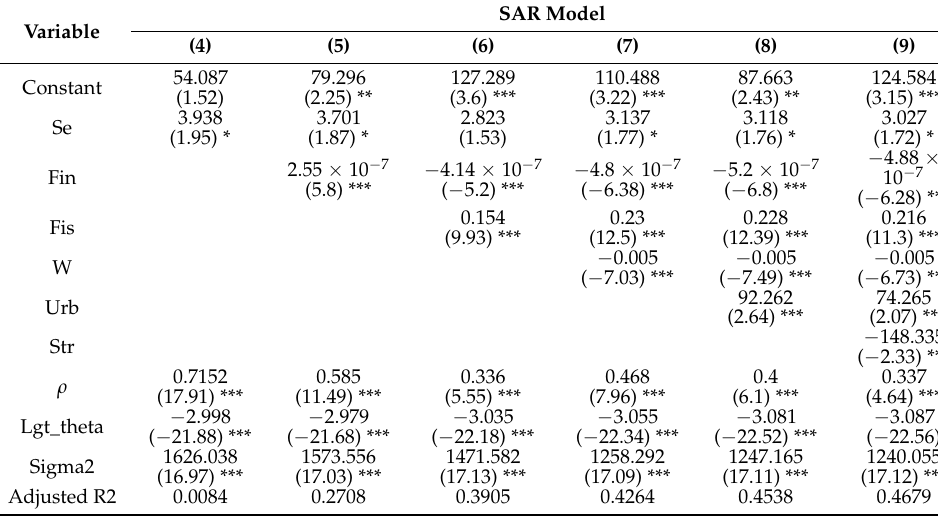
Table 3. Estimation results of spatial effect by using SAR